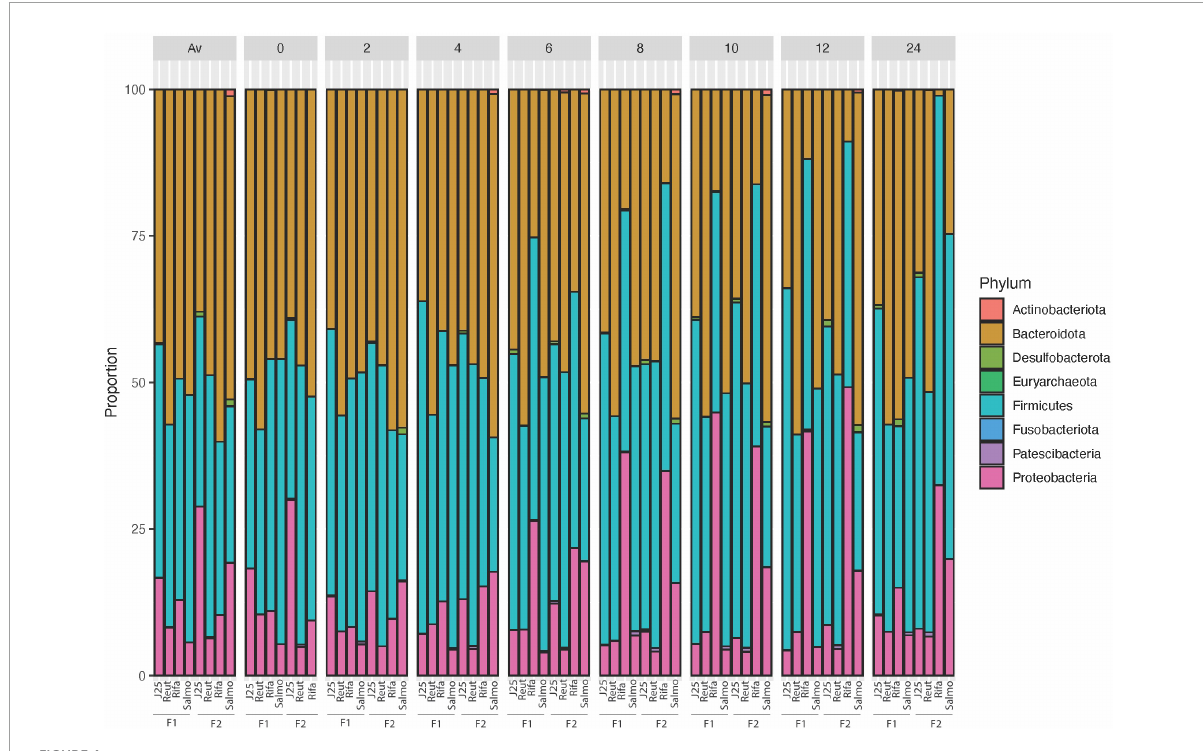
FIGURE4 16S rRNA gene-based microbial community structure of porcine microbiota after inoculation of Salmonella Newport alone (Salmo) and in combination with MccJ25 (J25), reuterin (Reut) or rifampicin (Rifa). The relative abundance of amplicon sequence variants ASV (%) are represented at the phylum level and samples are grouped at each time point for two independent fermentations (F1 and